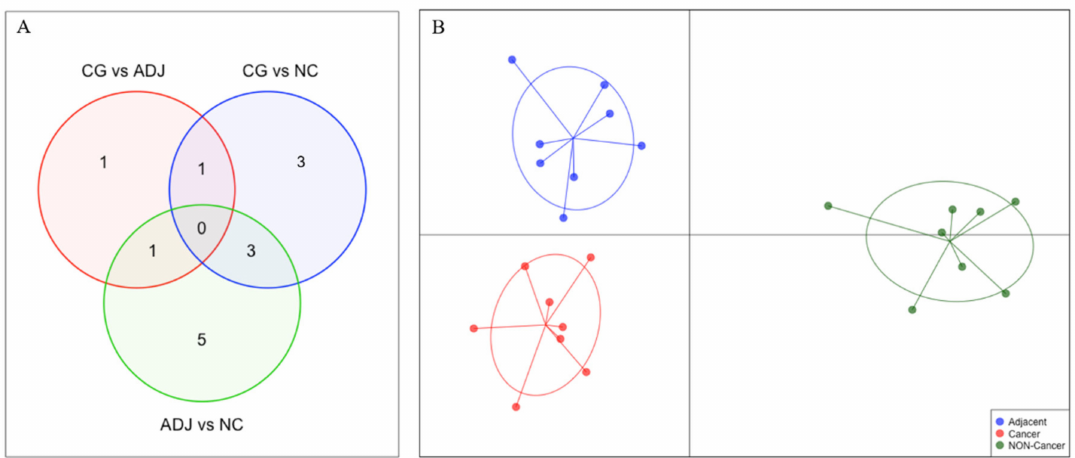
Figure 4. Comparison of the di ff erentially expressed piRNAs ( | fold-change | > 3 and p -value < 0.05) among all three analyses. ( A ) Venn Diagram identifying the number of di ff erentially expressed piRNAs in each comparison. ( B ) Discriminant analysis of principal components (DAPC) plot clustering samples based on di ff erentially expressed piRNAs.